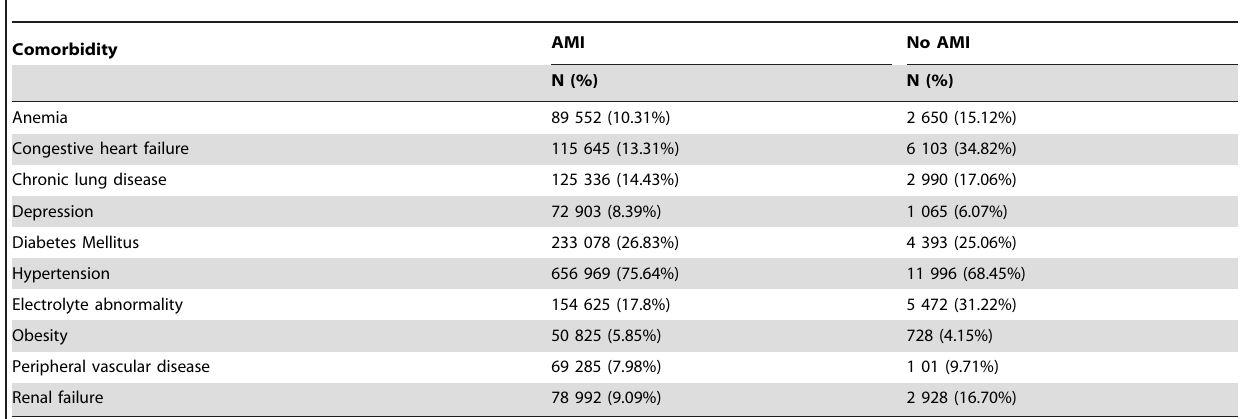
Table 3. Major comorbidities associated with